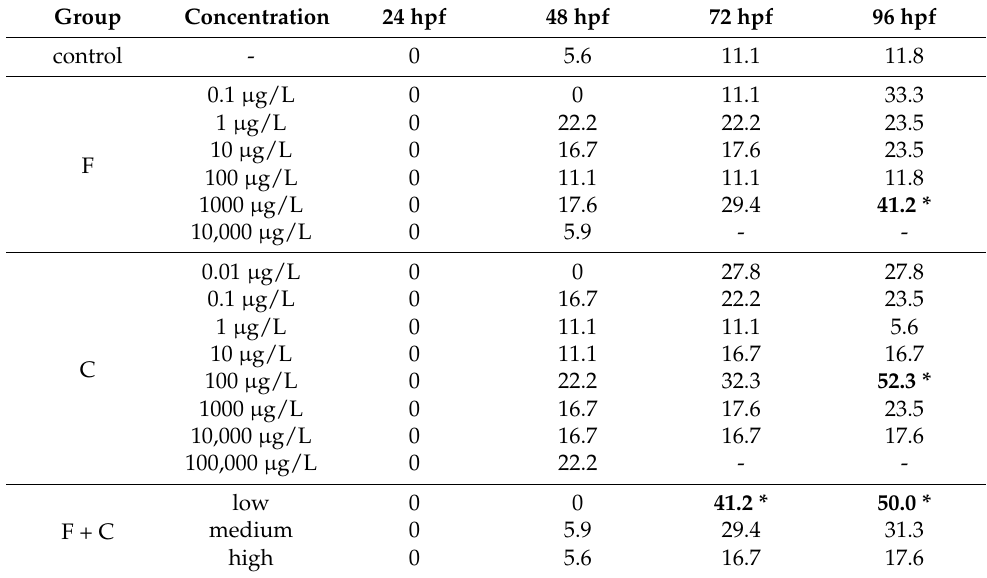
Table 4. Malformations (%) in African clawed frog embryos exposed to antidepressants as single substances and as a mixture. The results are related only to living individuals. Bold font and asterisks indicate a significant difference (* p < 0.05) between the control and the experimental groups at the same time of